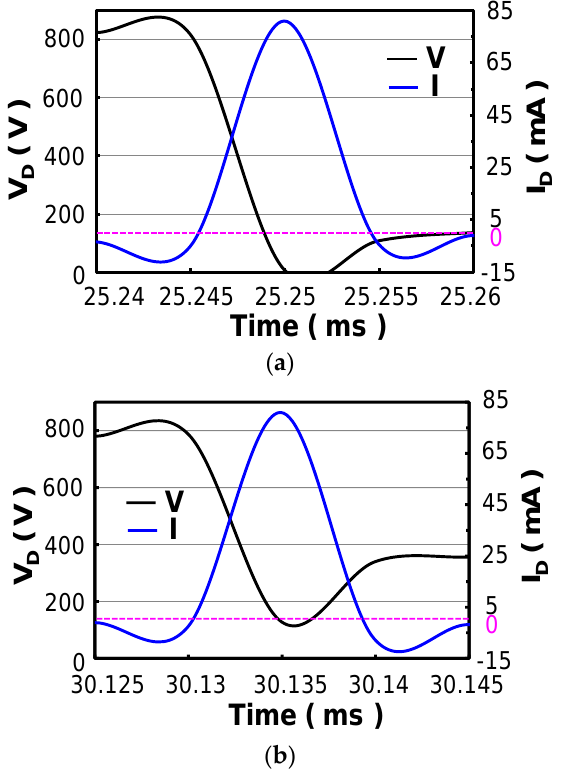
Figure 8. Zoomed – in view of the voltage and current waveforms in Figure 5b, during the time pe- Figure 8. Zoomed–in view of the voltage and current waveforms in Figure 5b, during the time riods ( a ) a1 and ( b ) a2 . periods ( a ) a1 and ( b )